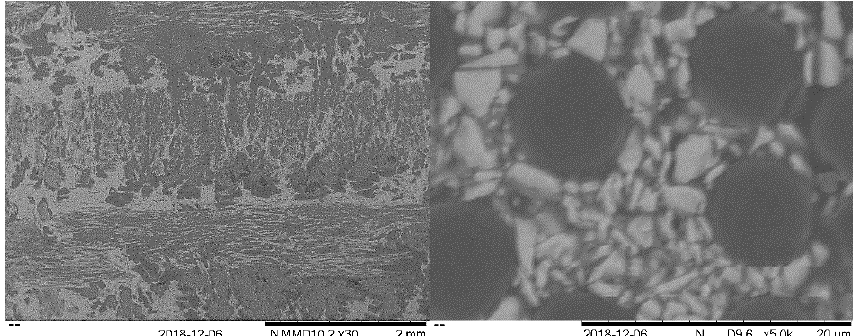
Figure 2. SEM images of the starting UHTCMCs at low and high magnifications.